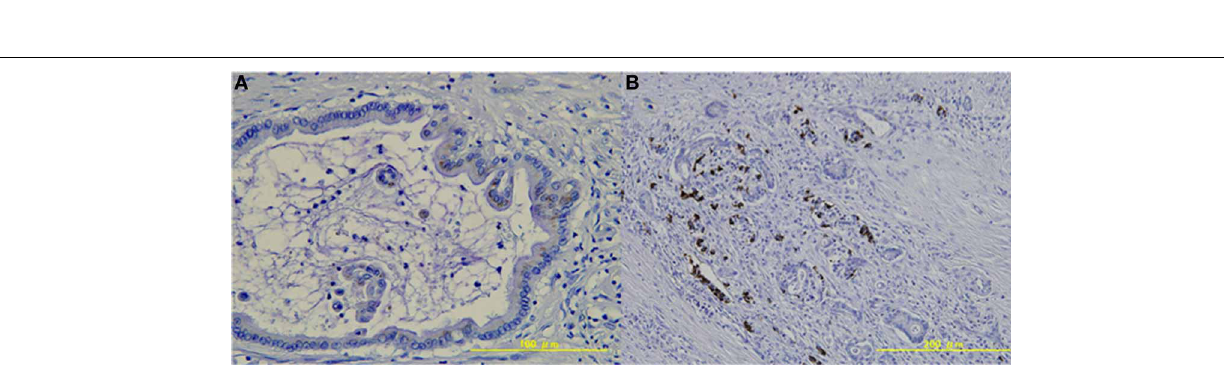
FIGURE 2 | Expression of LGR5 in pancreatic tissue. (A) LGR5 was weakly positive in the cytoplasm of pancreatic cancer cells. (B) LGR5 was strongly positive in the basolateral membrane of the remaining endocrine cells in non-neoplastic